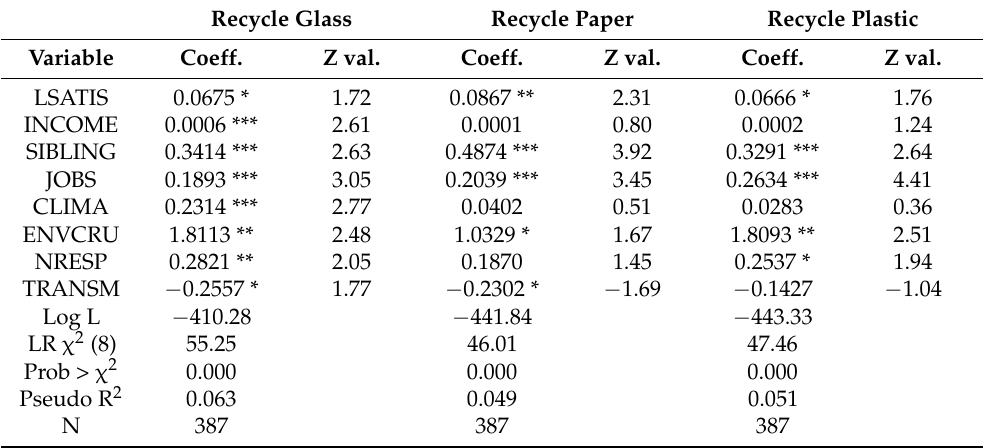
Table 4. Estimated parameters for recycling behaviors (low-cost PEB): ordered probit regressions. Recycle Glass Recycle Paper Recycle